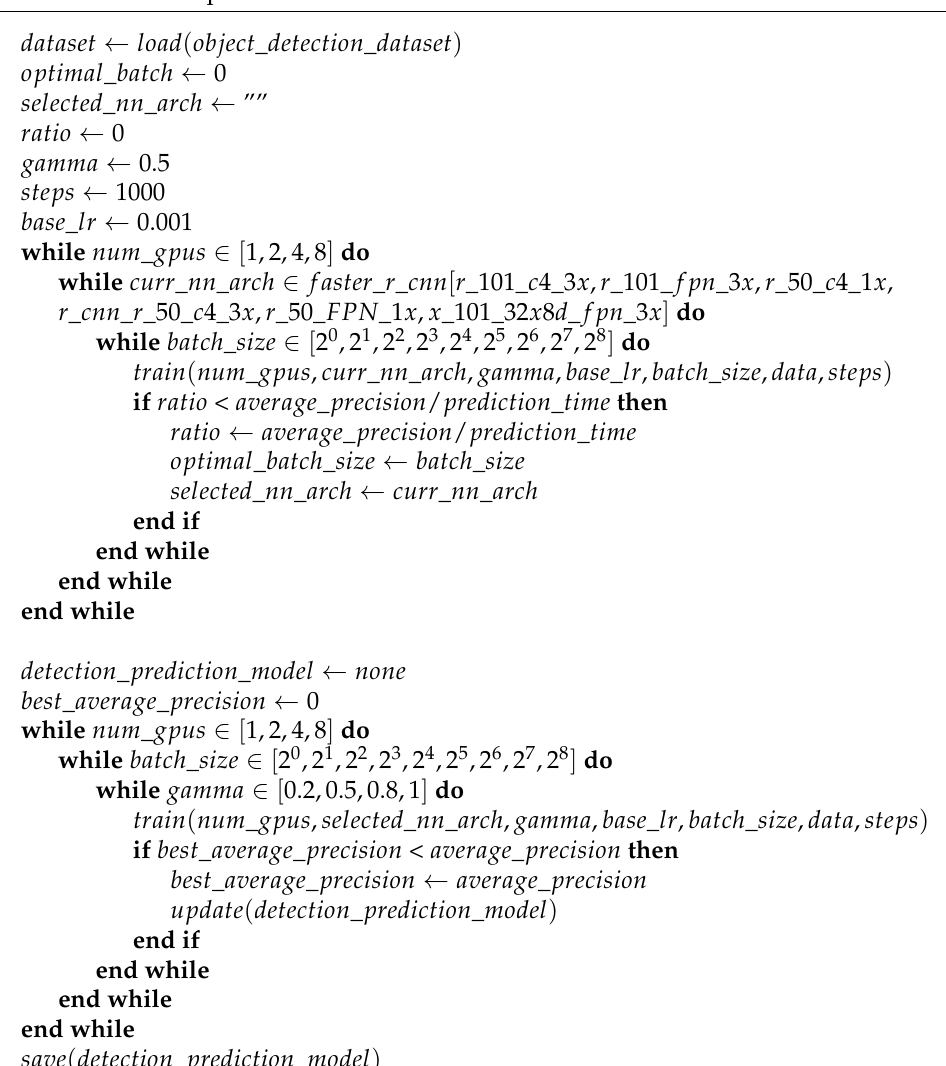
Algorithm 1 Object detection: implementation steps needed to select the network architec- ture and create the prediction